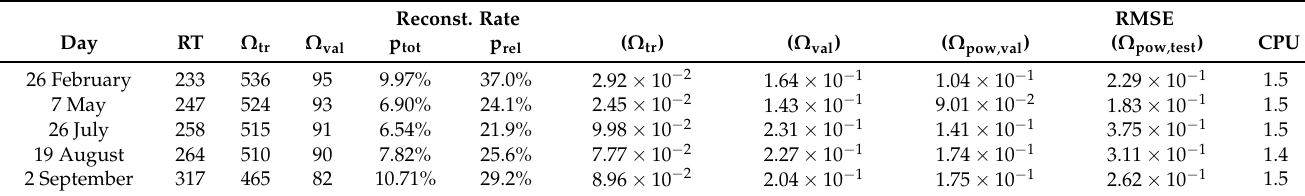
Table 1. Reconstruction results on days from the Sample_75 group. The reported statistics are averaged over 50 runs.